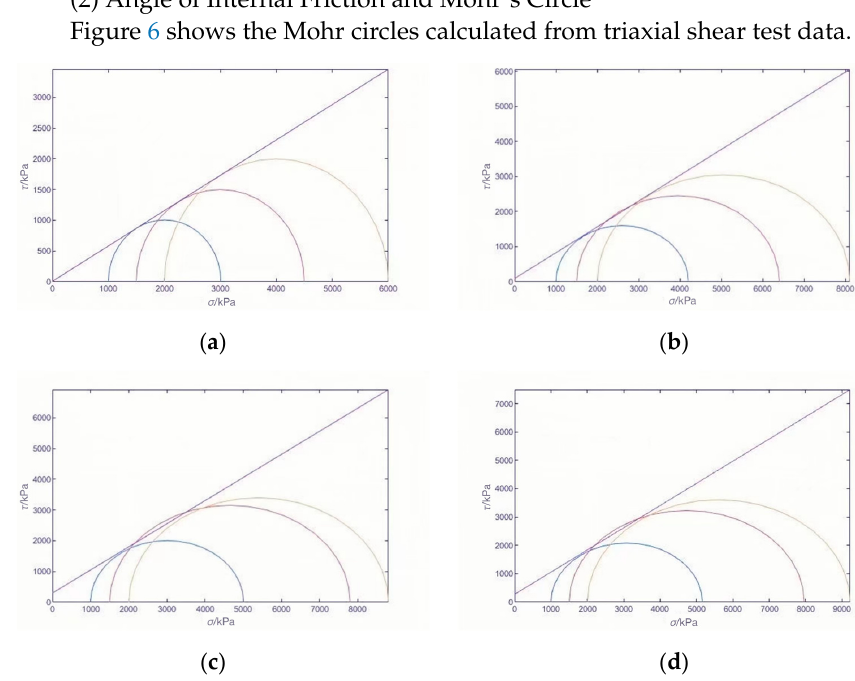
Figure 6. Mohr circles of hydrate deposits with different saturations. ( a ) Mohr circle at 0% saturation. ( b ) Mohr circle at 15% saturation. ( c ) Mohr circle at 25% saturation. ( d ) Mohr circle at 35% saturation.